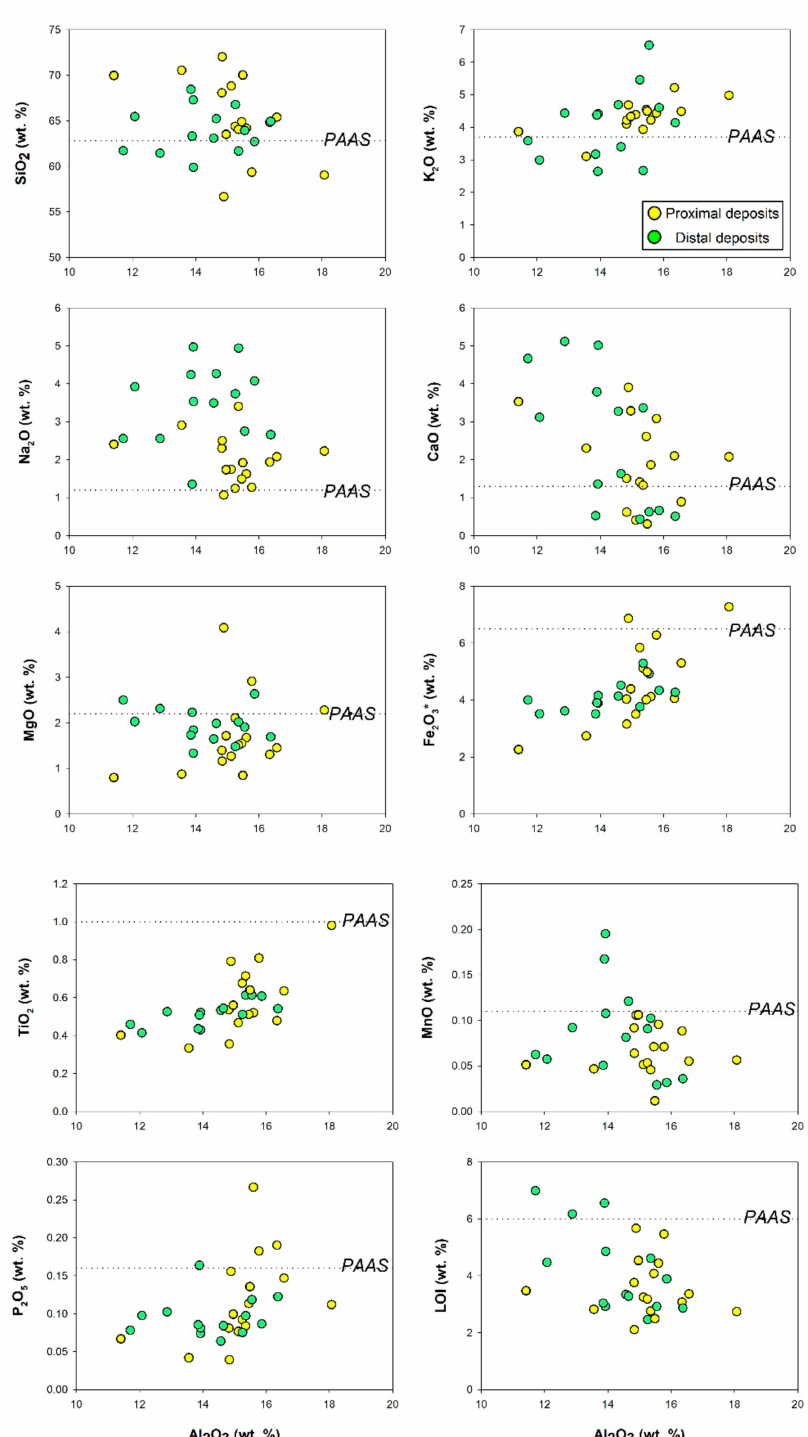
Figure 7. Binary plots of major elements versus Al 2 O 3 for the mudstone samples. The proximal and distal deposits are clearly distinguished in terms of the Na 2 O